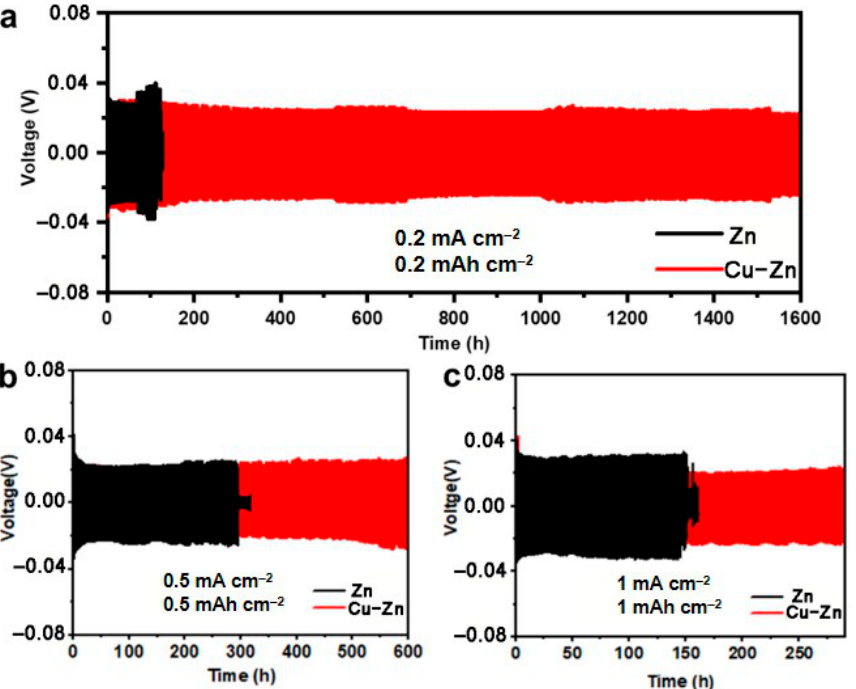
Figure 3. Long-term galvanostatic discharge/charge profiles of symmetric cells with bare Zn and Cu–Zn at current density of ( a ) 0.2 mA cm − 2 , ( b ) 0.5 mA cm − 2 , and ( c ) 1 mA cm − 2 .